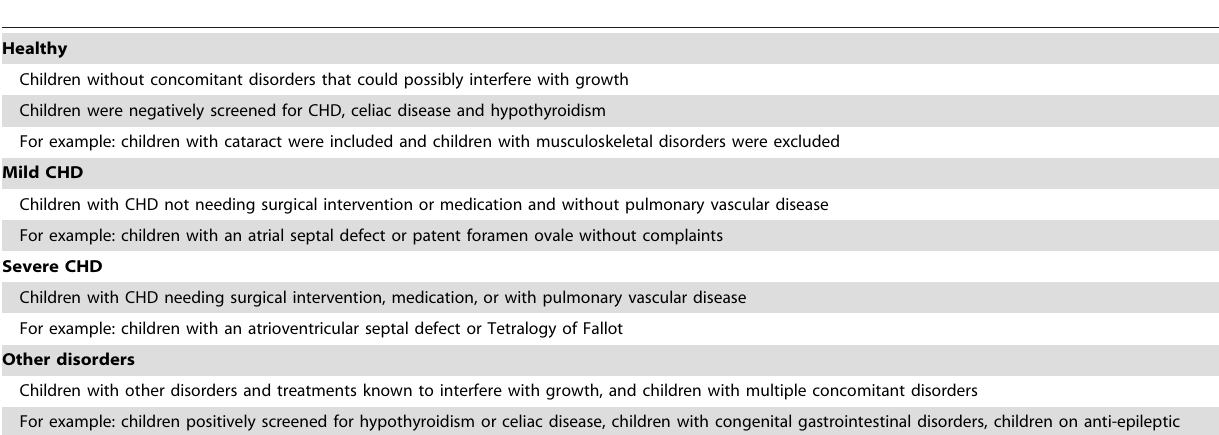
Table 1. Characteristics of the various health categories in the study population of children with Down syndrome.